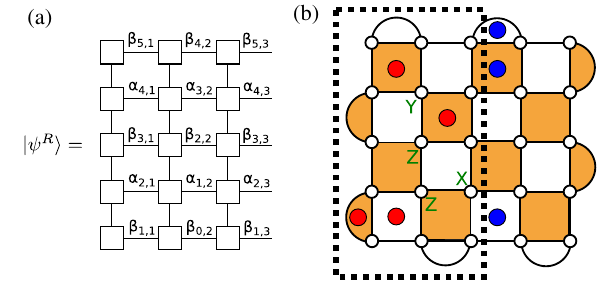
FIG. 16. (a) A boundary state obtained by contracting the network up to a given column and leaving the right-going indices of that column uncontracted. (b) An example check and error configuration illustrated for calculating the boundary state for the third column j ¼ 3 of a 5 × 5 code with rotated layout. A bulk configuration α B ; β B is represented by the red dots, and a boundary configuration α R ; β R is represented by the blue dots (where a dot on a check indicates that the check variable α or i;k β is 1). An error f 0 is represented by green letters. Note that for i;k this calculation we consider only the action of the checks and error on qubits in the first three columns Q 3 , inside the dashed box. So the action on the boundary checks on qubits outside the box is ignored. The quantity T 0 ð α B ; β B ; α R ; β R Þ is the probability of the product of all dotted checks and the error f 0 in the dashed box. In the example configuration depicted above, this product contains four X , six Y , and two Z errors, giving T 0 ð α B ; β B ; α R ; β R Þ ¼ p 4 p 6 p 2 p 3 . In order to calculate the boun- X Z Y I dary state, all possible configurations of bulk checks must be summed over. In the special case of pure Y noise, where 0 , only at most one term in this sum is nonzero p p X ¼ Z ¼ for any boundary